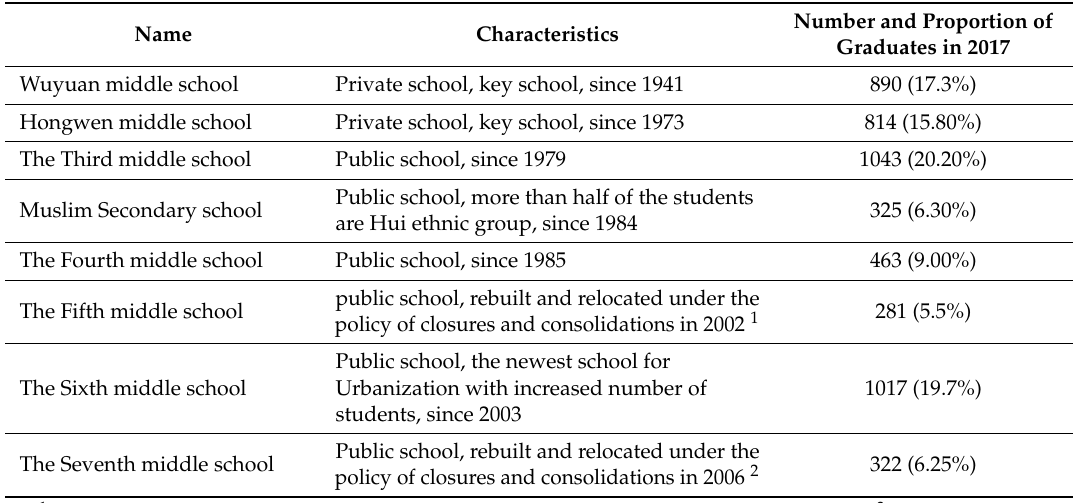
Table 1. Characteristics of the eight middle schools in Guyuan,